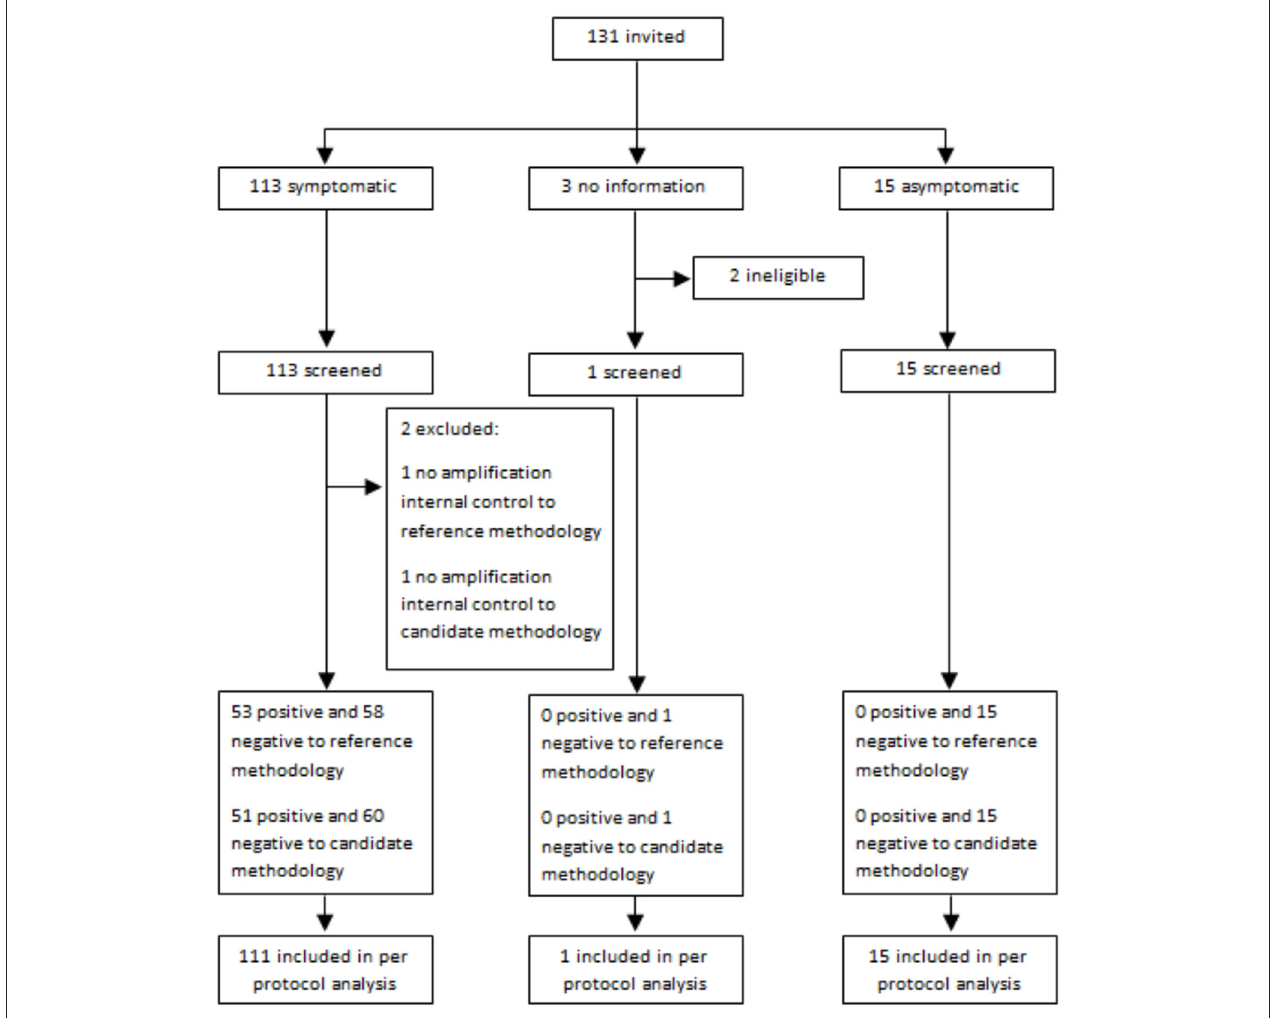
FIGURE 1 | Flow of